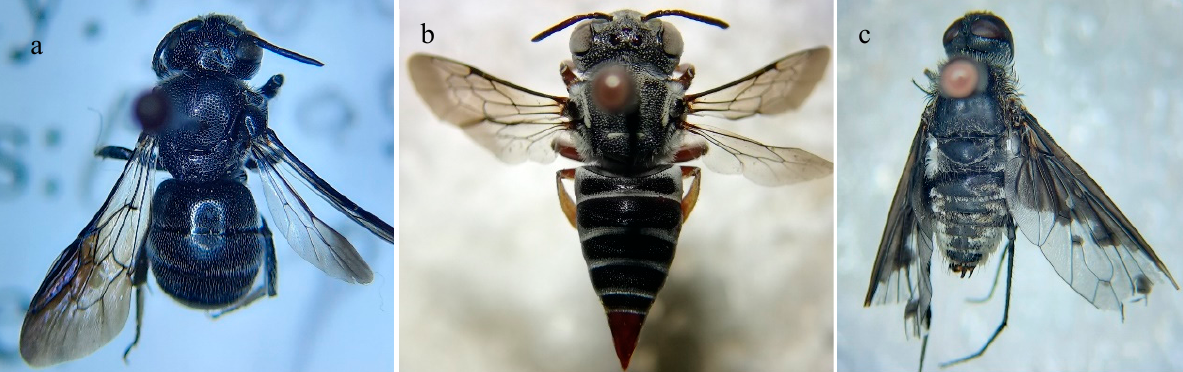
Figure 6. Parasitoids of Megachile cephalotes ( a ) Euaspis carbonaria , ( b ) Coelioxys sp., and ( c ) Anthrax sp.